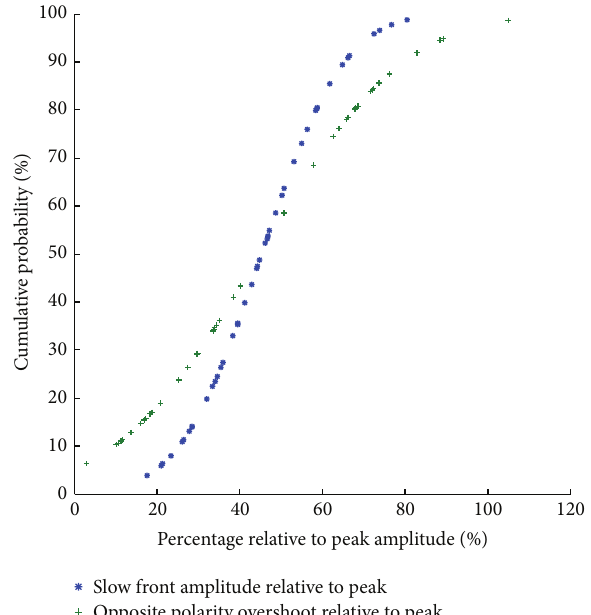
Figure 13: Cumulative probability distribution of the slow front amplitude and the opposite polarity overshoot relative to peak.